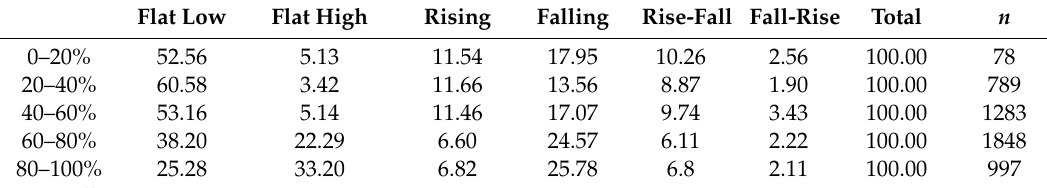
Table 8. Profile distribution by FVR, expressed in % of each bin.